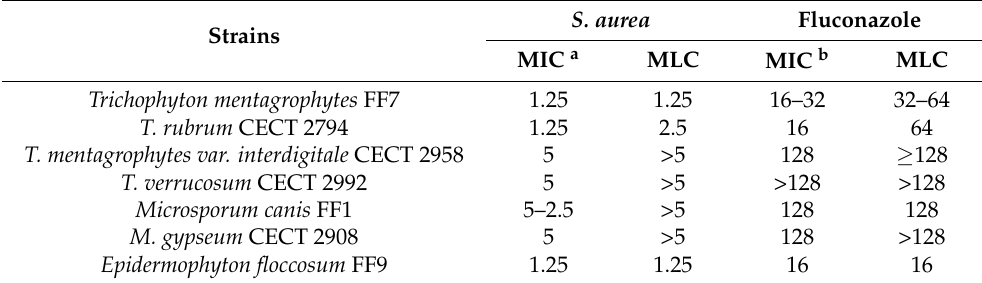
Table 2. Minimum inhibitory (MIC) and lethal (MLC) concentrations of S. aurea essential oil against dermatophytes.